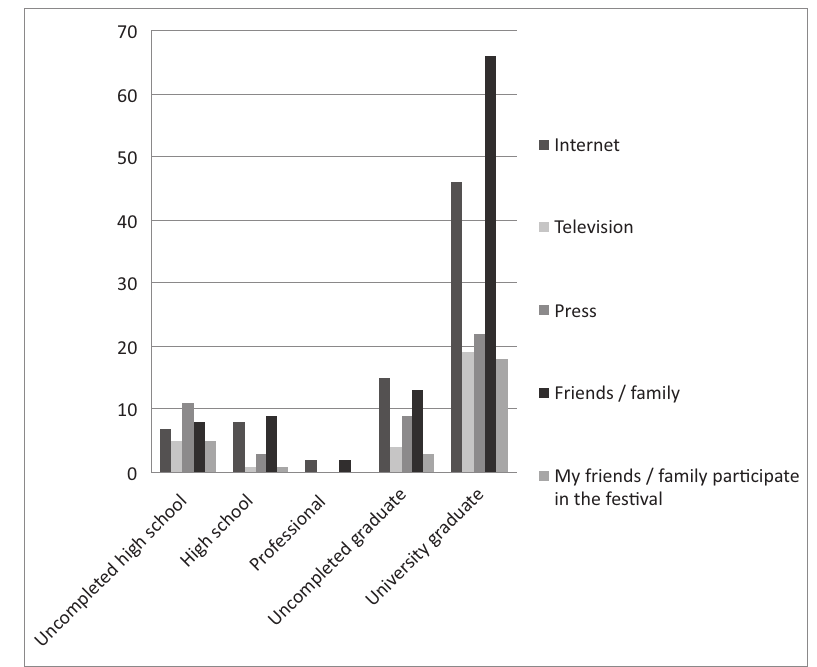
Fig. 18. Correlation between a channel visitors have found information about the festival and